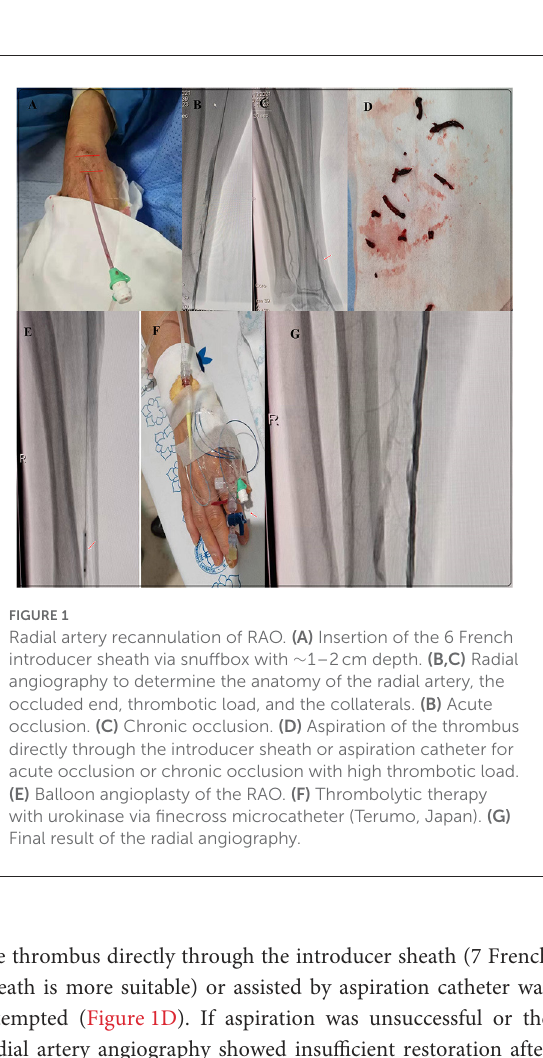
(Figure 1E). Continuous thrombolytic therapy with urokinase via finecross microcatheter (Terumo, Japan) was given for